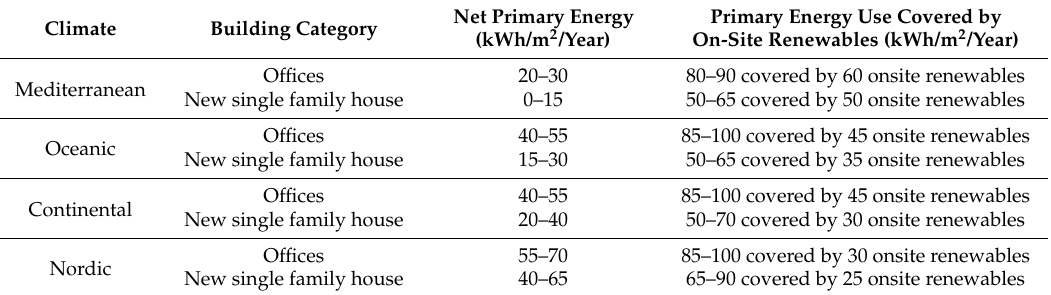
Table 3. Numeric benchmarks for nZEB primary energy use indicators at EU level source: